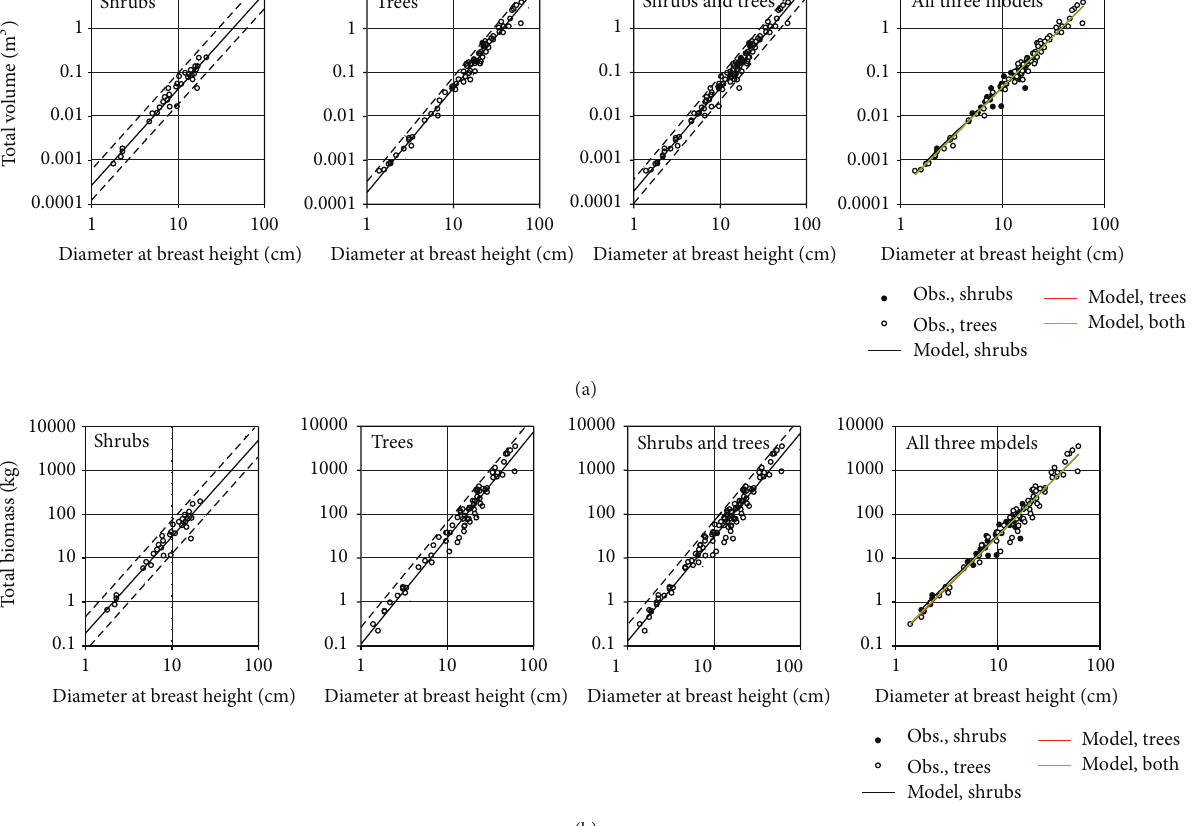
Figure 2: Model 4 for total volume (a) and biomass (b) of the three species groups: shrubs, trees, and shrubs and trees. First three columns: circles indicate observed values, unbroken lines show expected values, and dashed lines are 95% prediction intervals; fourth column: all three models (see